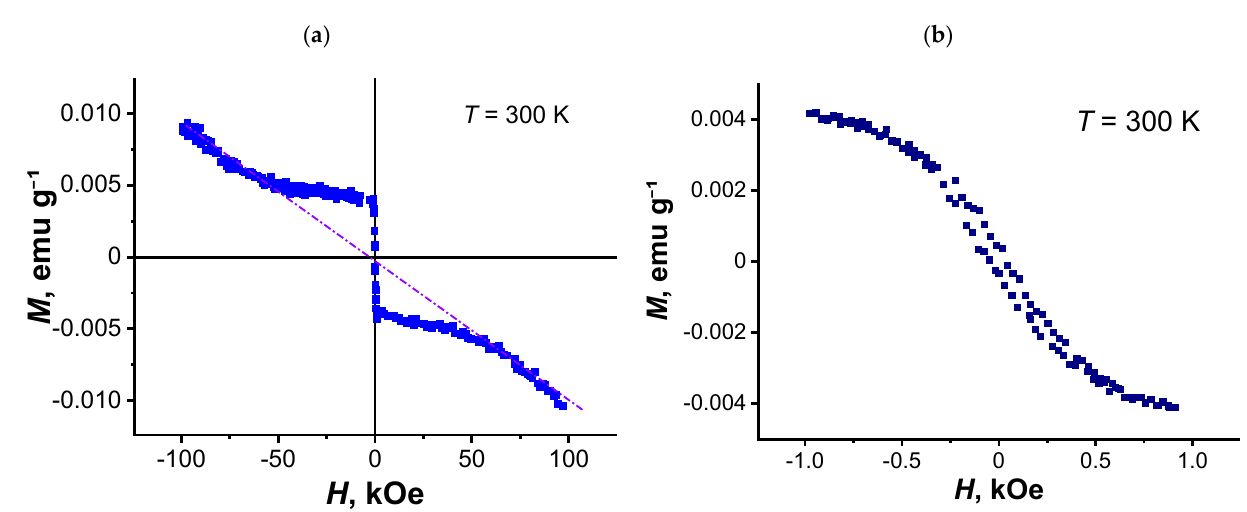
Figure 7. Dependence of the magnetic moment versus magnetic field for composite 1 at T = 50 and 300 K.